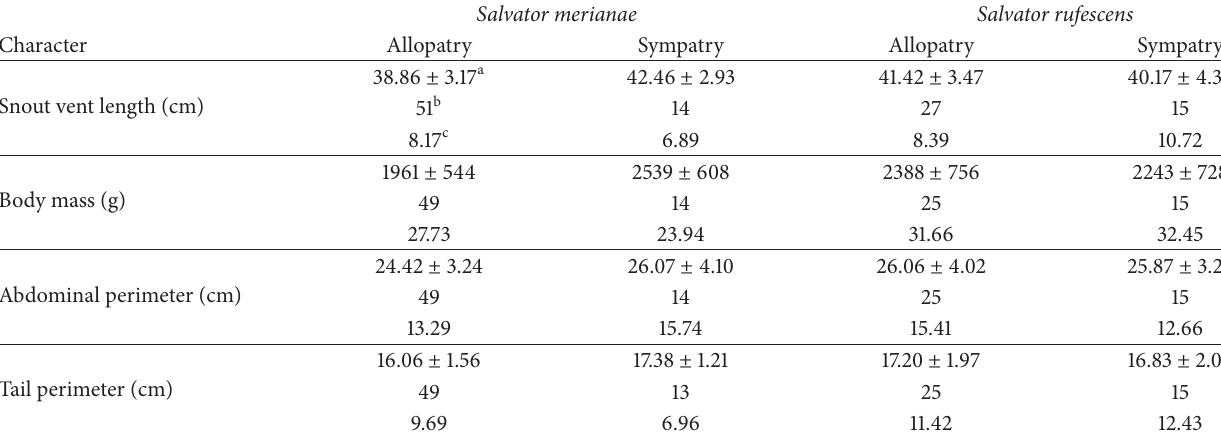
Table 1: Descriptive statistics of body size and robustness parameters for mature males during the reproductive period of the studied populations (allopatry and sympatry) in each species. Salvator merianae Salvator